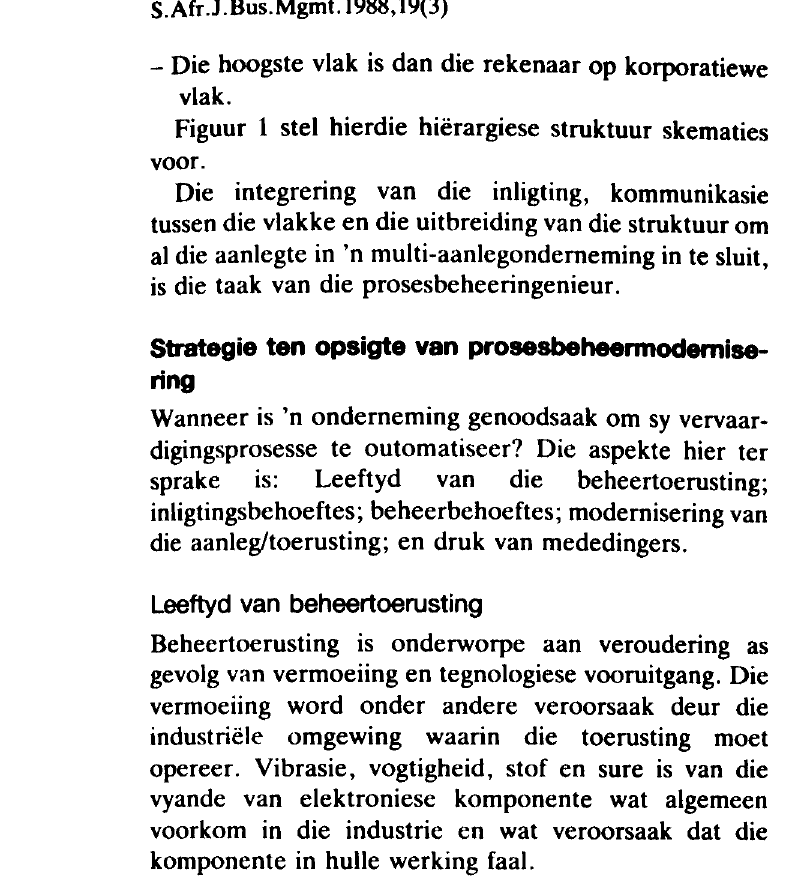
Figuur 1 stel bierdie bierargiese struktuur skematies